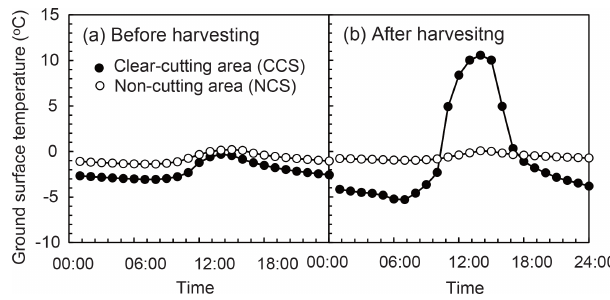
Figure 4. Average ground surface temperature before and after har- vesting at sites CC (CCS) and NC (NCS). (a) Before clear-cutting in the period 1 January to 29 February 2012. (b) After clear-cutting in the period 1 January to 28 February